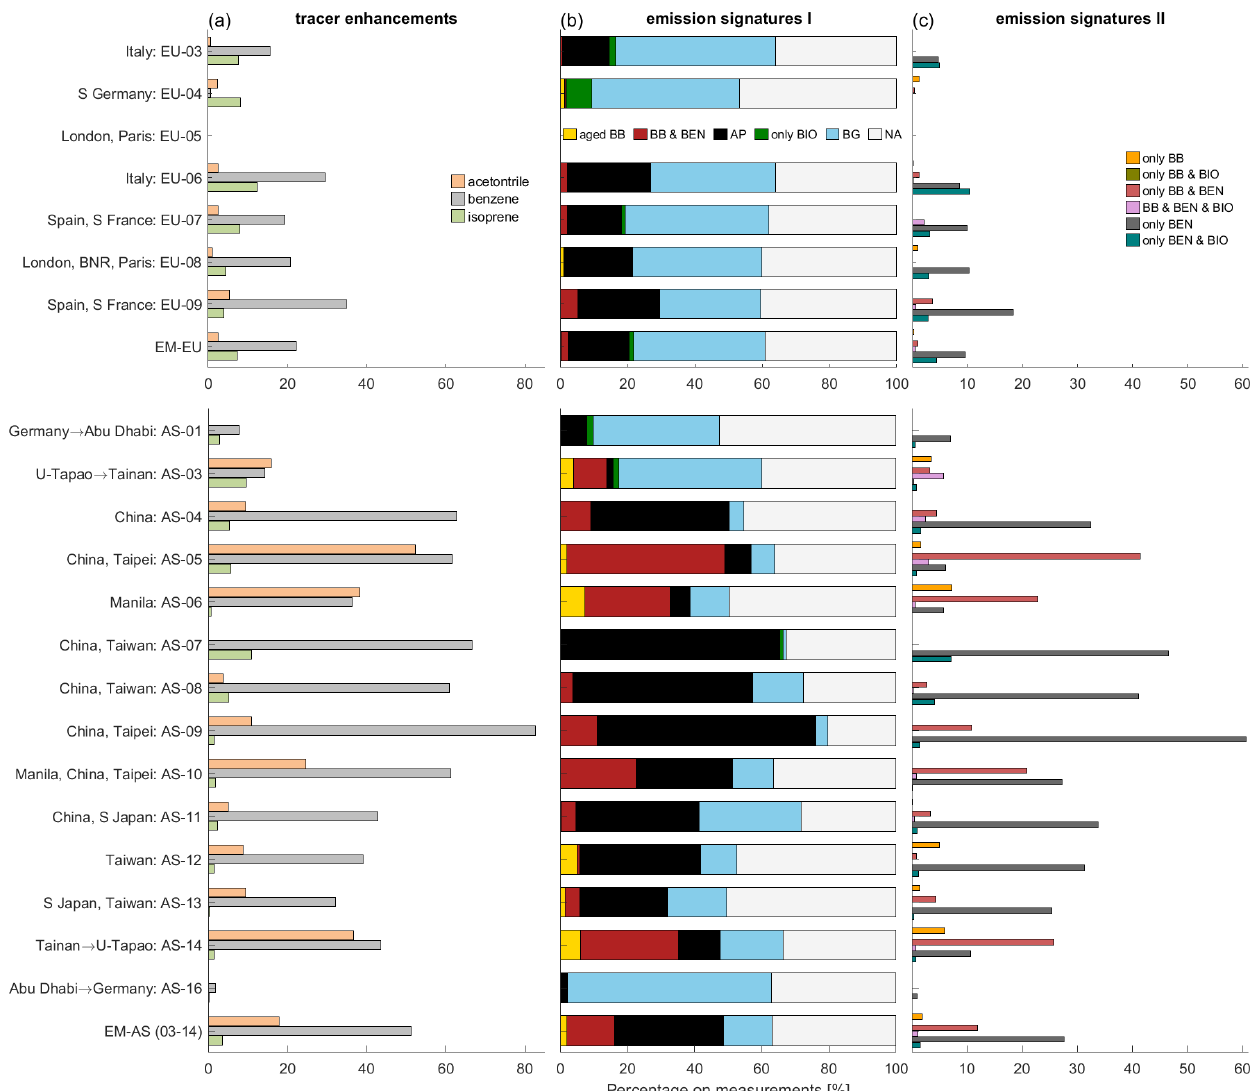
Figure 4. Fractions (%) of (a) enhancements over thresholds observed in acetonitrile, benzene and isoprene; (b) source signatures I (aged BB, BB & BEN and AP ∗ inferred from observed enhancements only in acetonitrile and benzene and only BIO and BG ∗ inferred with additional isoprene); and (c) source signatures II (inferred from observed enhancements in acetonitrile, benzene and isoprene). Top: EMeRGe-Europe, bottom: EMeRGe-Asia. EU-05 is not available due to instrument failure. The summary of EMeRGe-Asia excludes the non-Asian transfer flights AS-01 and AS-16. ∗ AP – anthropogenic signatures, BB – biomass burning signatures, BEN – benzene enhancements, BIO – fresh biogenic signatures, BG – background, NA – not assessable during instrumental background detection and threshold transitions (due to PTR-MS measurement resolution of 1min per